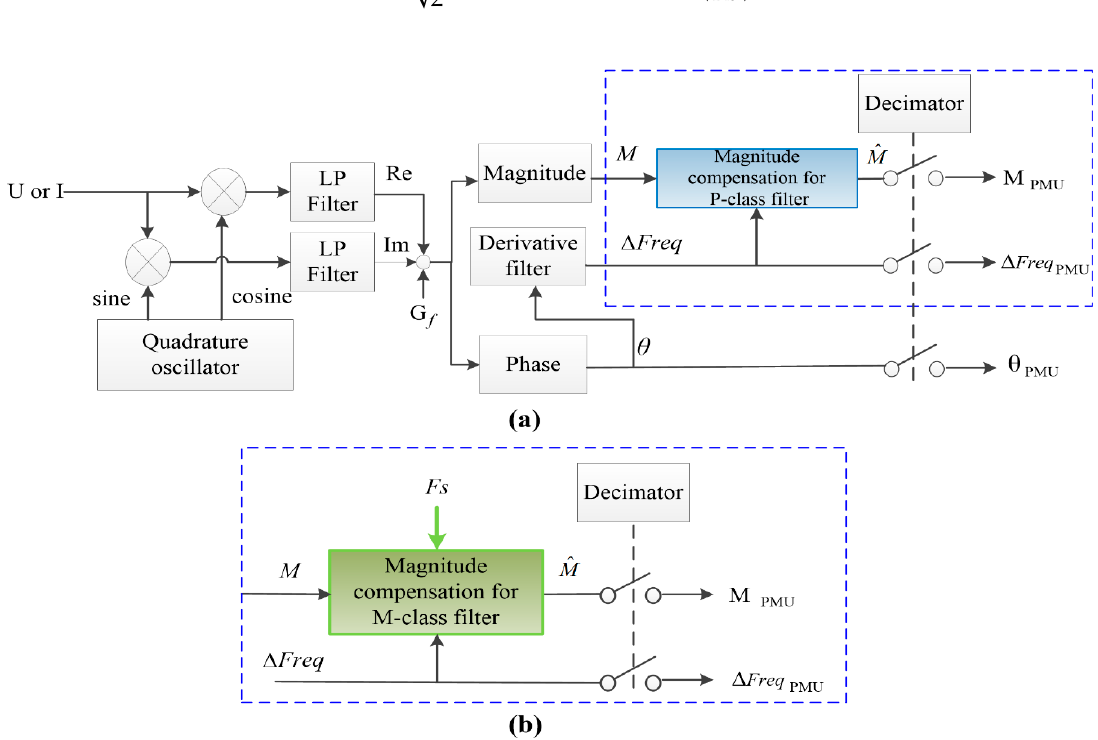
Figure 1. Phasor measurement unit (PMU): ( a ) Phasor signal processing algorithm for P-class PMU and ( b ) Proposed compensation for M-class PMU.